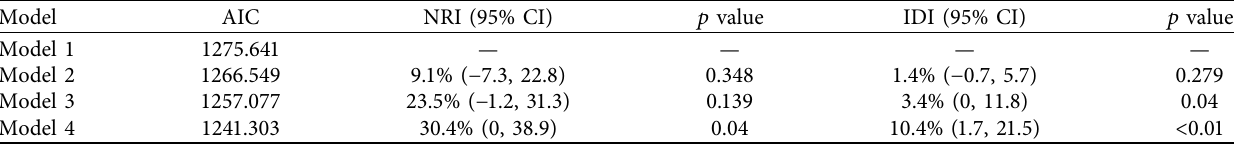
Table 3: Performance of models in prediabetes